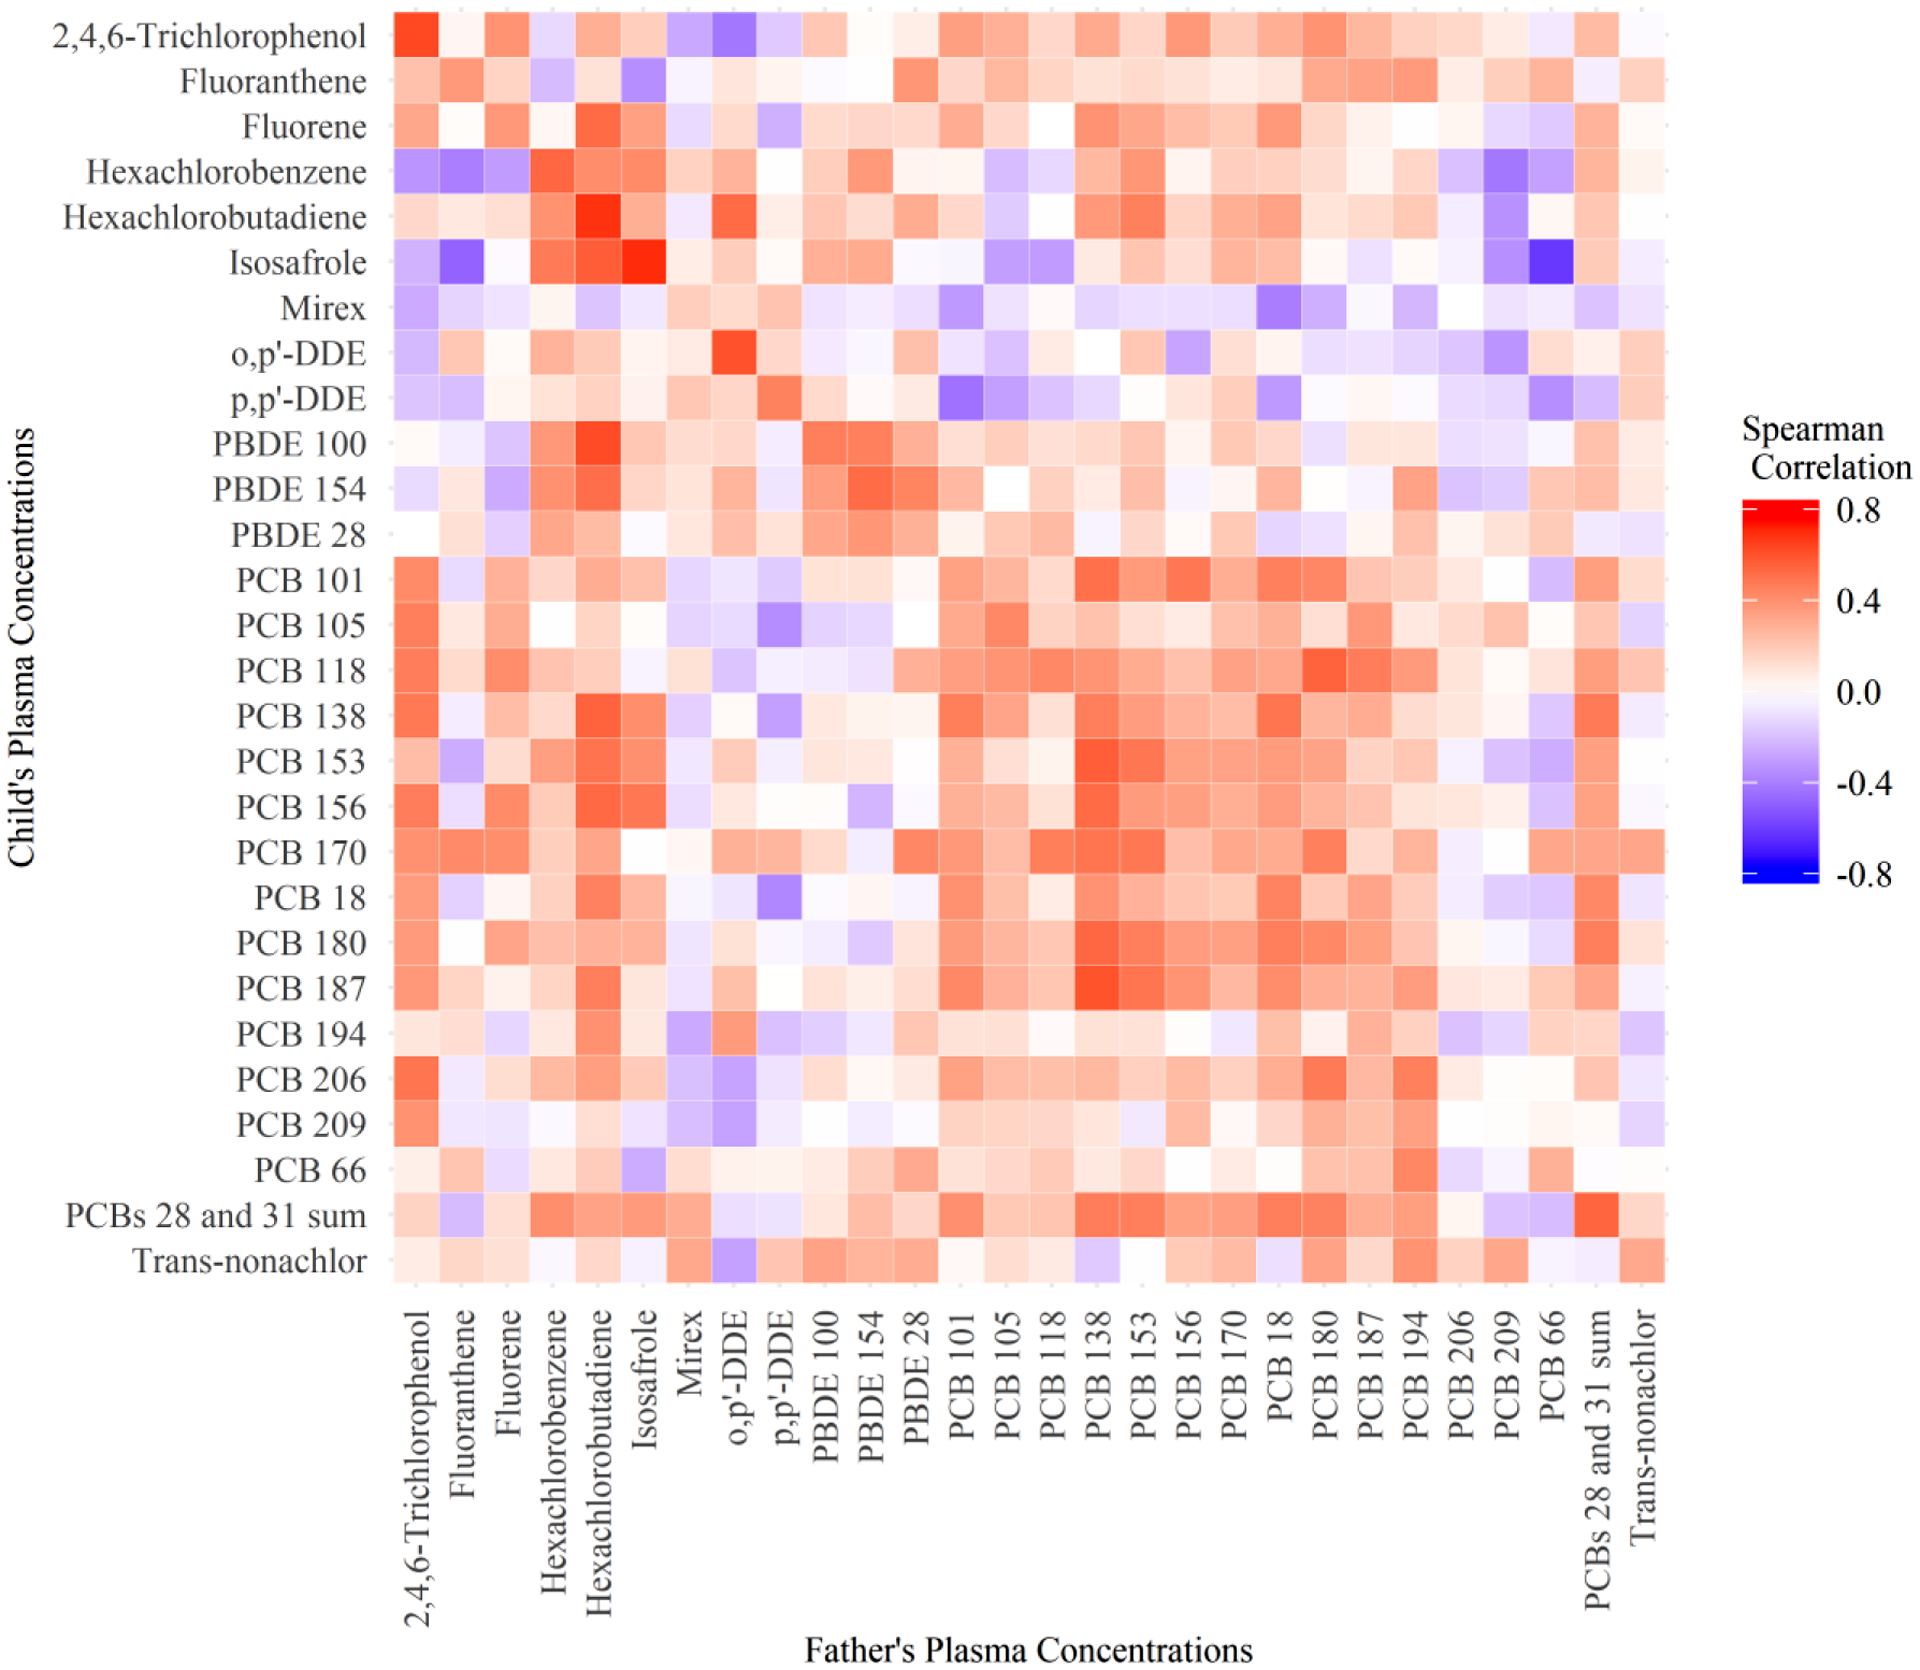
Correlation heatmap of children and their fathers’ plasma chemical concentrations. Higher correlation coefficients along the diagonal indicate pollutants which displayed similar concentrations between fathers and their children